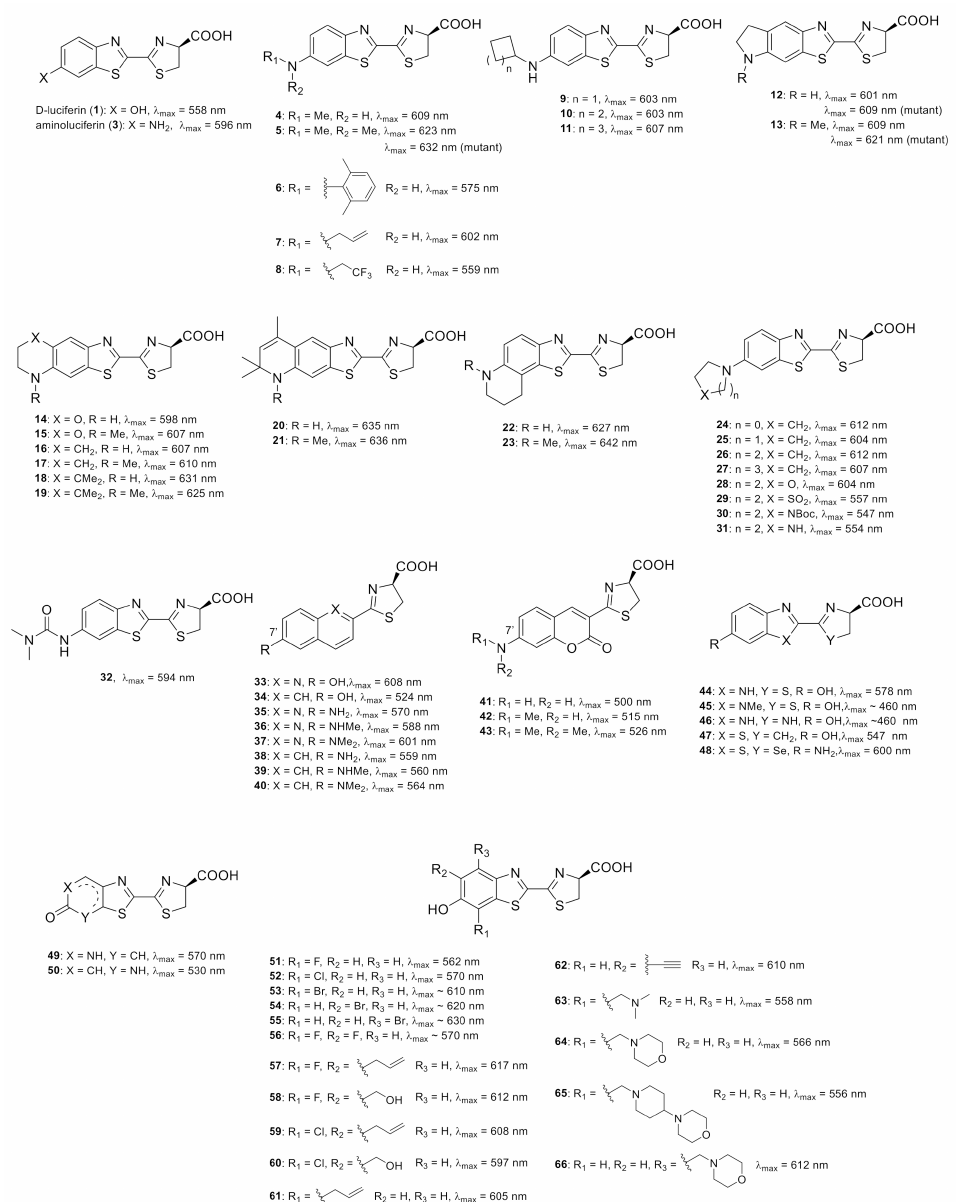
Figure 2. Chemical structures of substrates which were designed using substrate